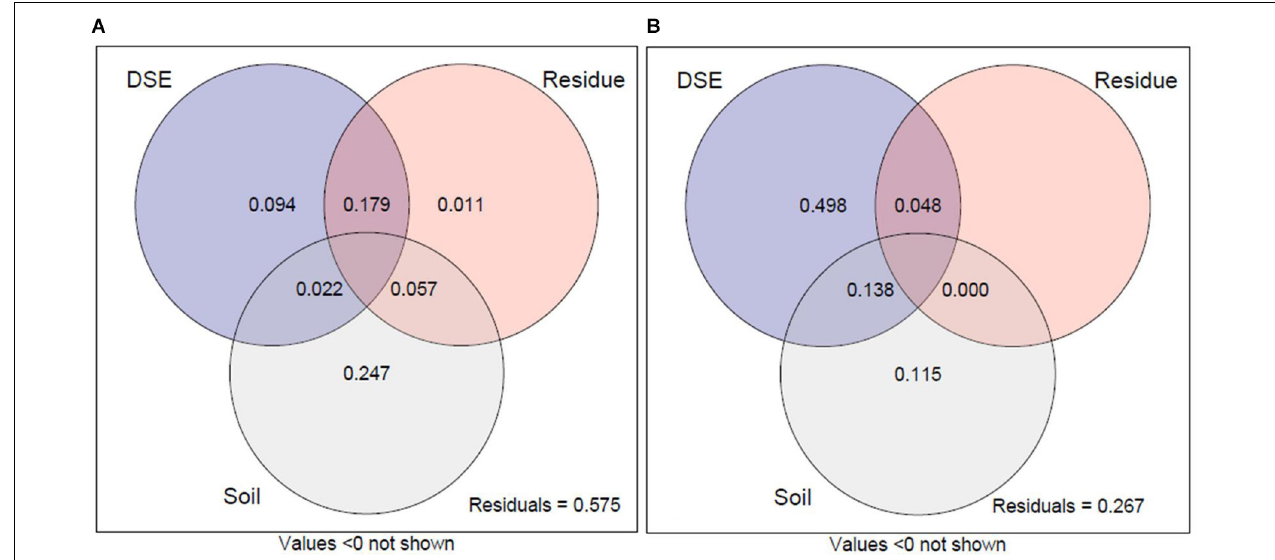
FIGURE 7 | Variation partitioning of DSE species, residues, and soil mineral nutrient on plant biomass, root morphology traits, and nutrient content (A) . Variation partitioning of DSE species, residues, and soil mineral nutrient on active ingredient contents in roots (B) . DSE, DSE species; Residue, liquorice residues; Soil, mineral nutrient content (including soil organic matter, available P, and available N). Values below 0 are not